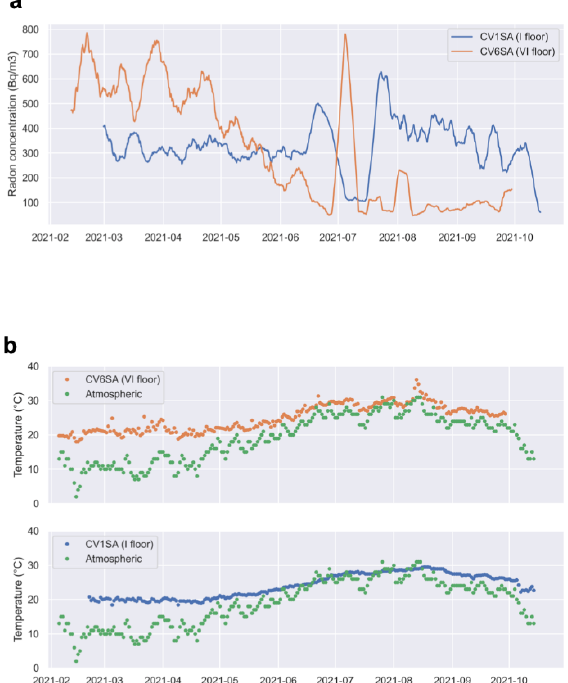
Figure 10. ( a ) The 1-week rolling mean of radon concentration (Bq/m 3 ) measured in the rooms CV1SA, and CV6SA, on the I and VI floors (blue and orange lines, respectively). ( b ) daily temperature measured in the same rooms and atmospheric Temperature (green circles).